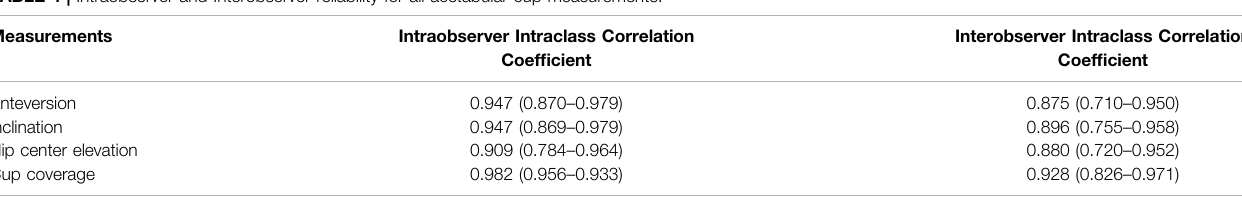
TABLE 4 | Intraobserver and Interobserver reliability for all acetabular cup measurements.